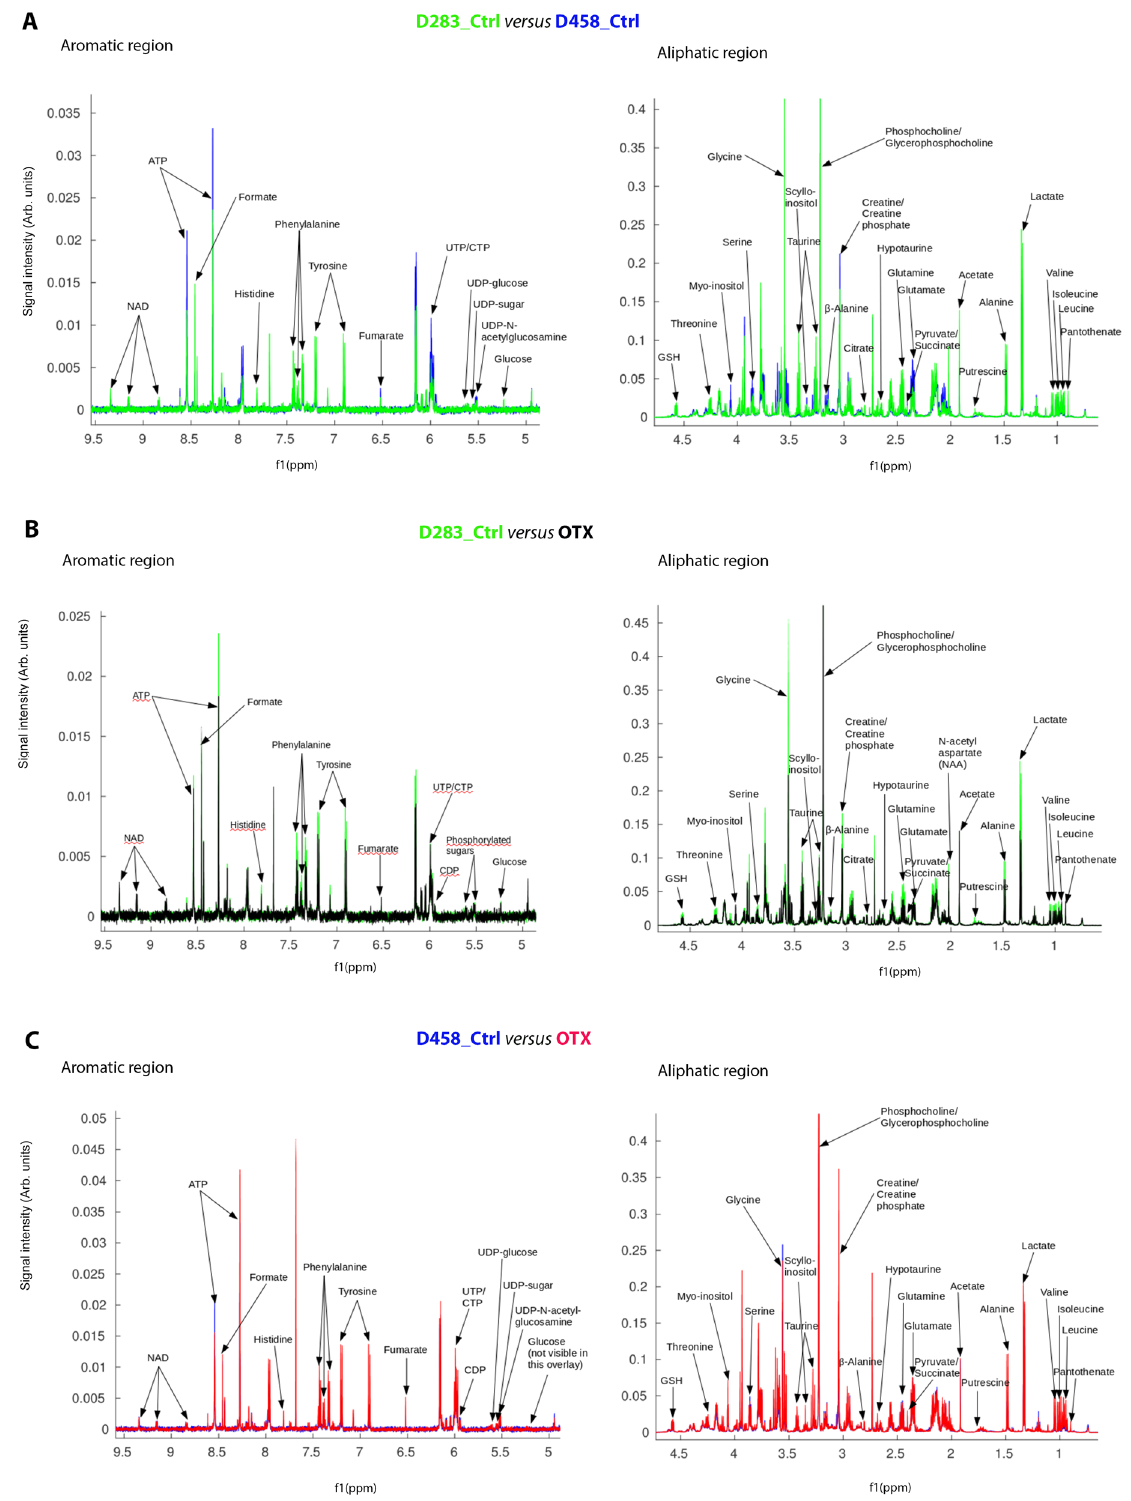
Figure 2. Aligned and normalised overlays of representative one-dimensional 600 MHz 1 H NMR spectra of cellular extracts from control and OTX-015 treated cells, focussing on aliphatic and aromatic regions. ( A ) D283 (D283_Ctrl, green) versus D458 (D458_Ctrl, blue); ( B ) D283 control (D283_Ctrl, green) versus OTX-015 treated (D283_OTX, black) and ( C ) D458 control (D458_Ctrl, blue) versus OTX-015 treated (D458_OTX, red) cell lines. Selected peaks of identified metabolites are